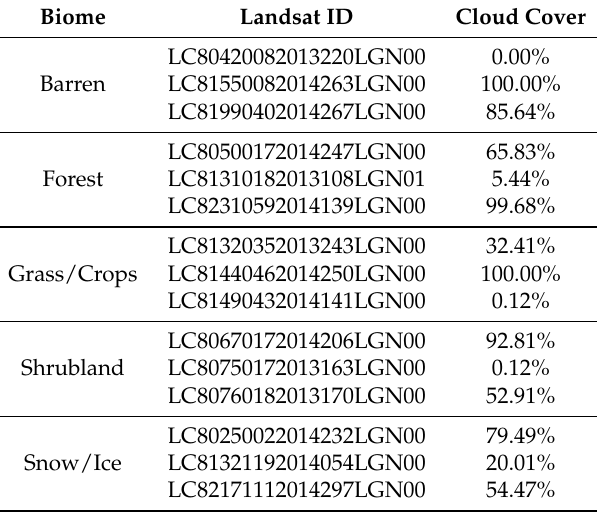
Table A1. Landsat ID and Cloud Cover of the 24 training